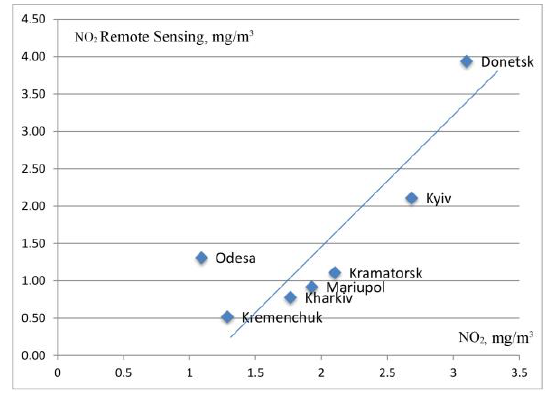
Figure 1. The relationship between ground observations data and remote sensing data NO2